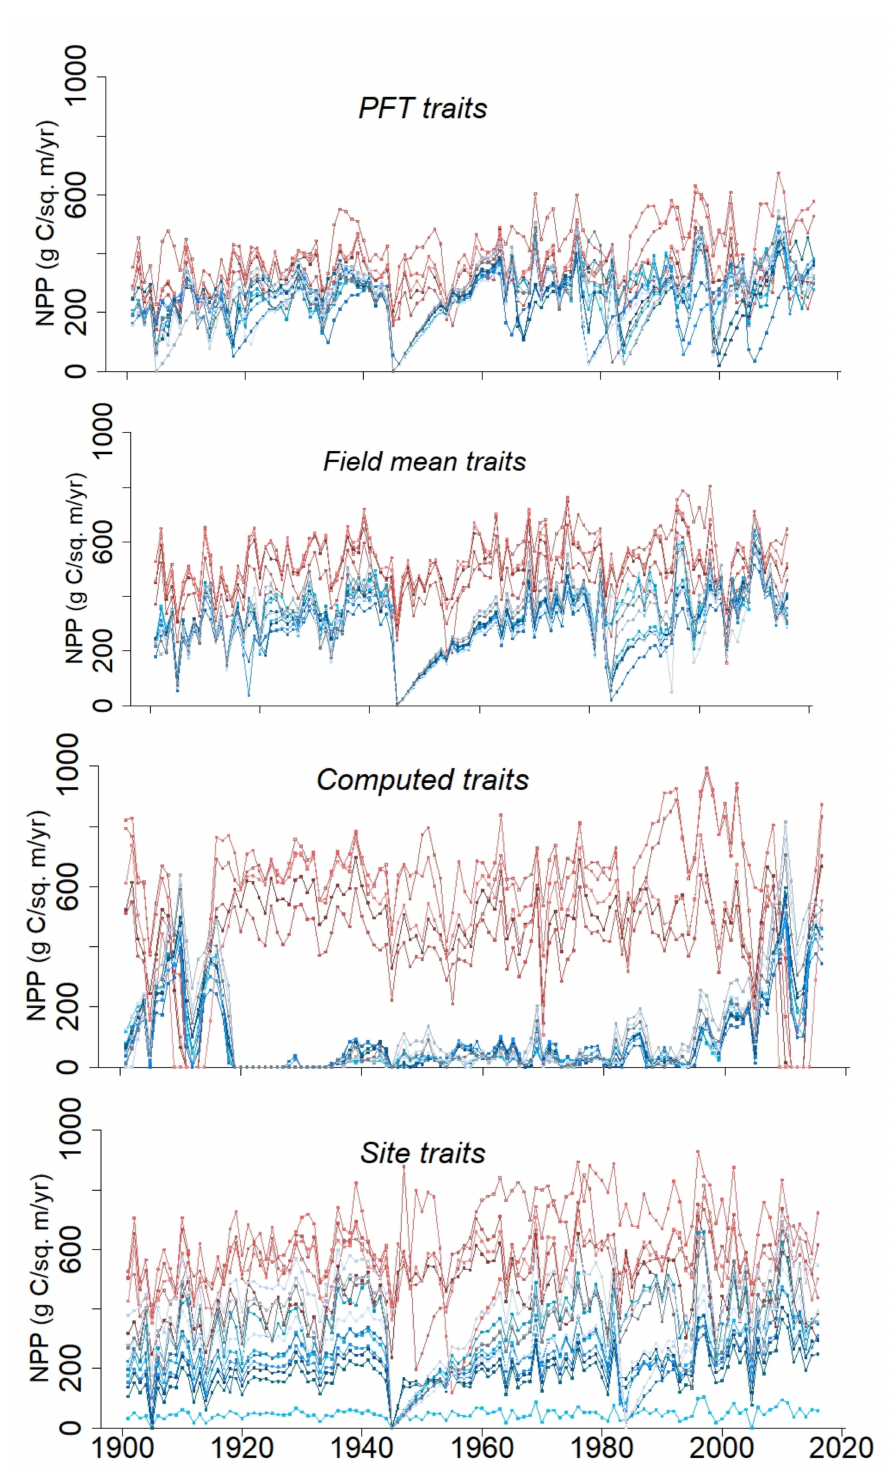
Figure 7. Simulated net primary productivity (NPP) between 1900 and 2016 over the sampling locations (Middle Atlas in blue colors, Rif in reds) using PFT traits , field mean traits , computed traits and site traits